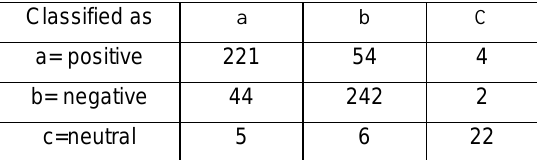
Table 5. Proposed Confusion matrix of BON